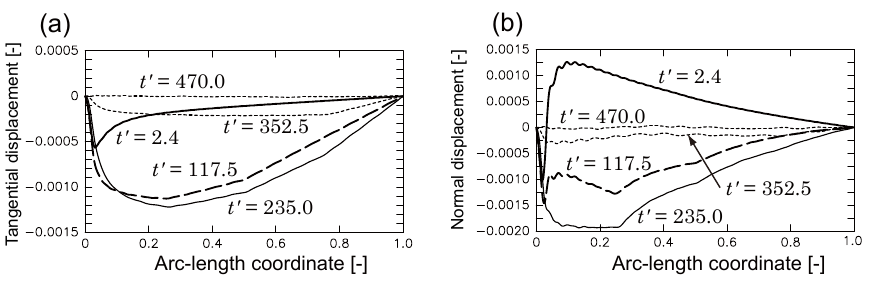
Figure 10. Time histories for the generalized coordinates of the lowest four modes in case of four buckets: ( a ) tangential component and ( b ) normal component.